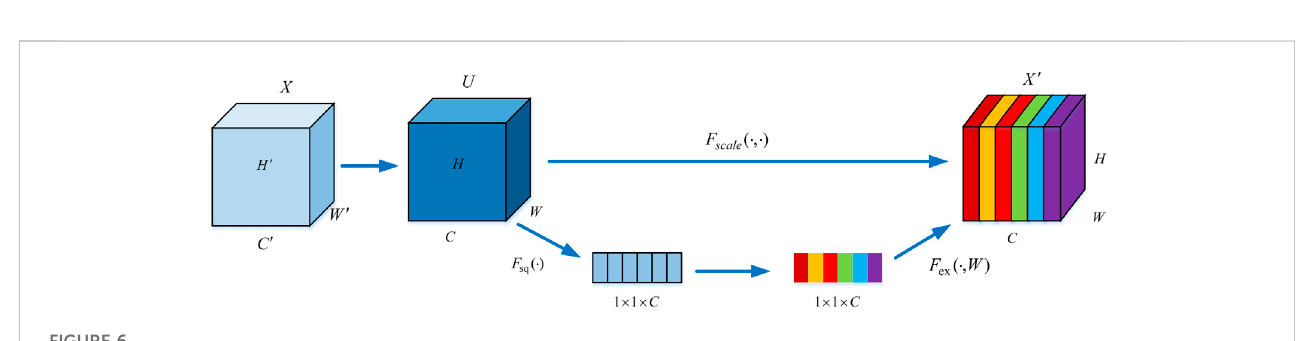
FIGURE 6 SE channel attention